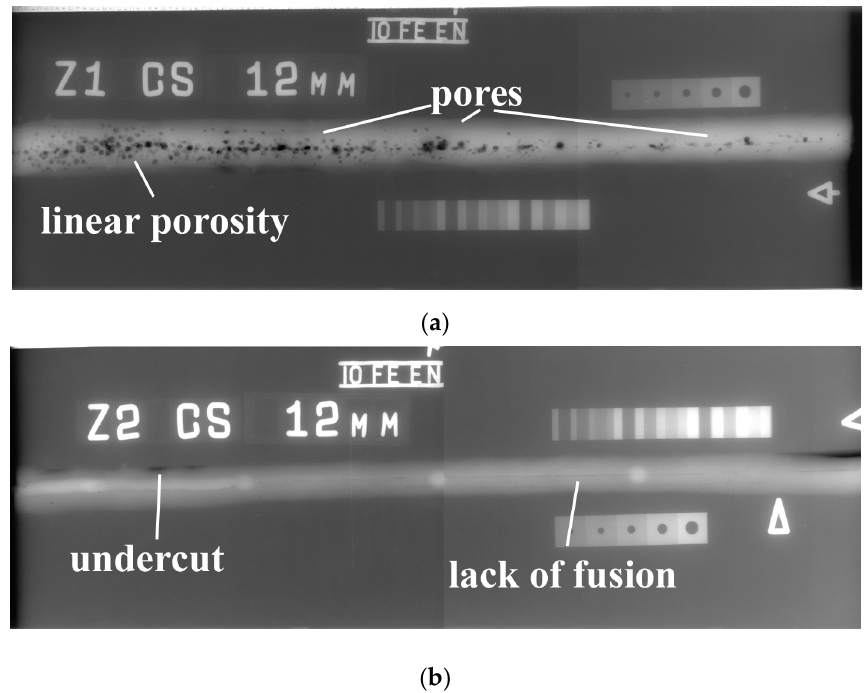
Figure 7. Radiograms: ( a ) s pecimen SW and ( b ) s pecimen SA.